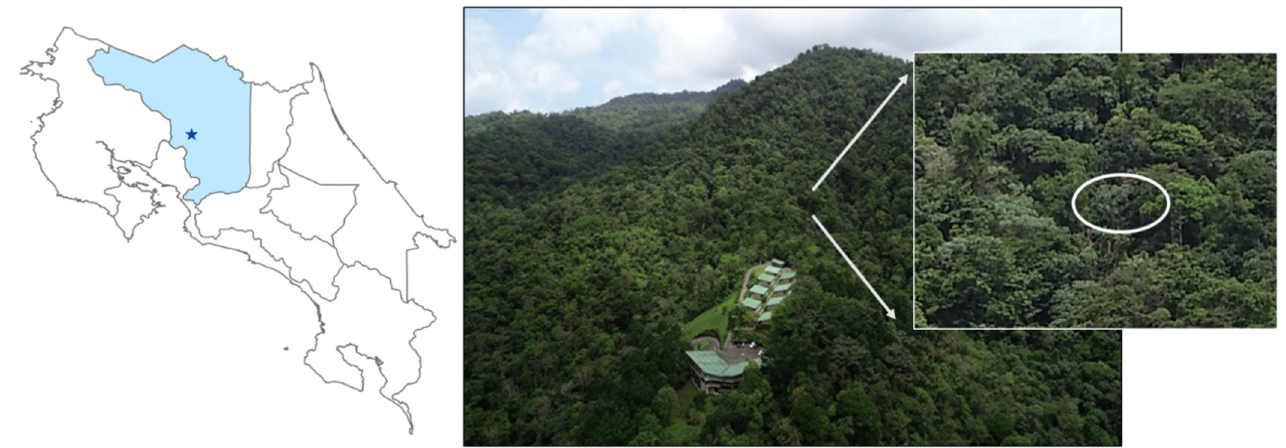
Figure 2. Map of Costa Rica with the Soltis Center’s location along with an aerial UAV photo of the Soltis Center and the surrounding forest that marks the site the M. anisophyllum before its death (circled in inset). Photo credits: Elizabeth M. Prior and Kelly Brumbelow.